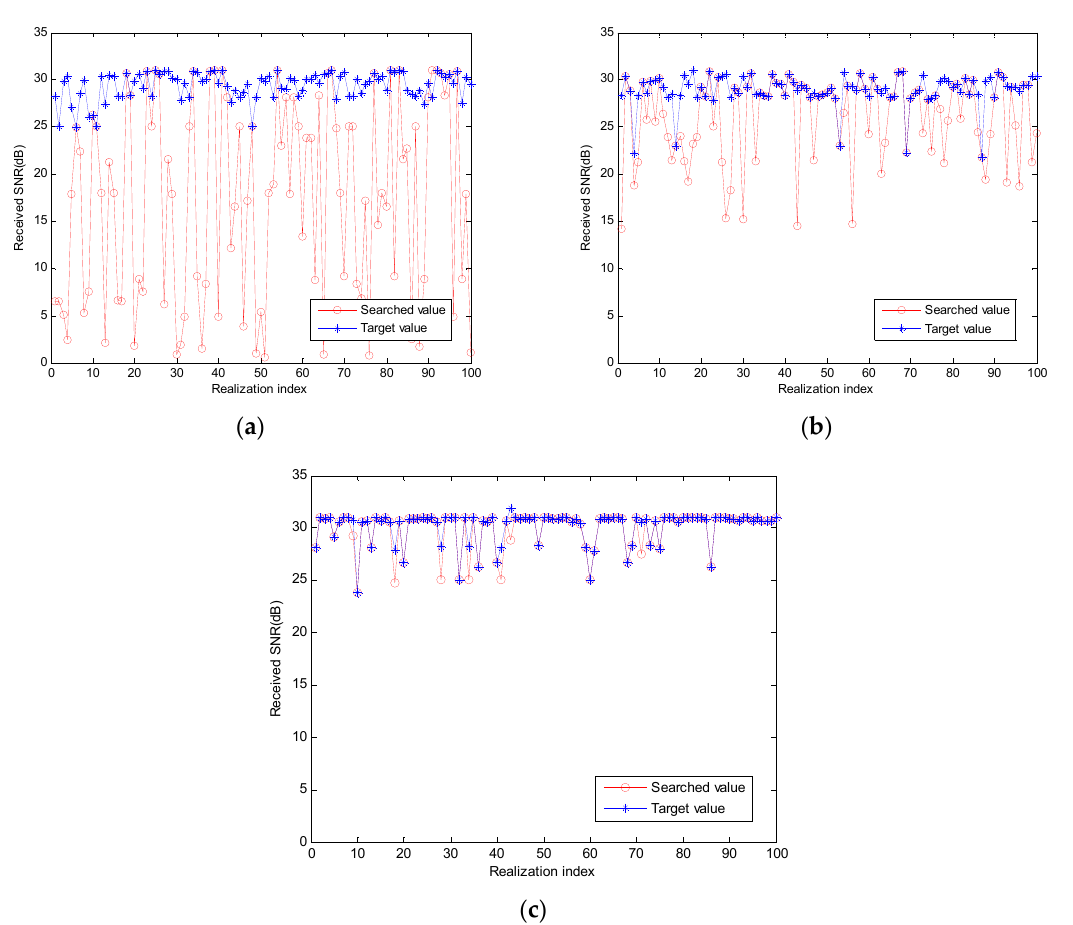
Figure 3. Performance of the Rosenbrock search in mm Wave beam training. ( a ) Classical Rosenbrock algorithm; ( b ) RA + SA ; ( c ) RA + SA + TS